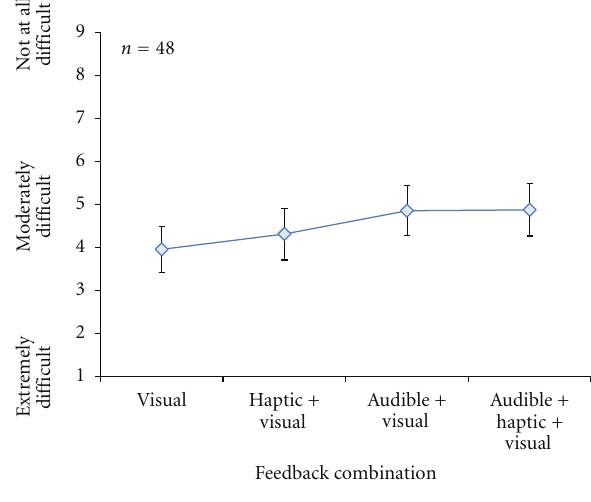
Figure 12: Touchscreen task di ffi culty rating.